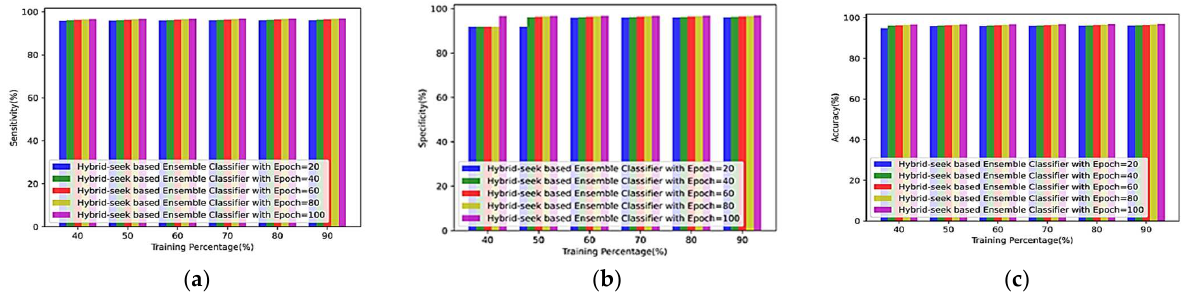
Figure A1. Analysis of performance using CHB-MIT database in terms of training % ( a ) accuracy, ( b ) sensitivity, and ( c )